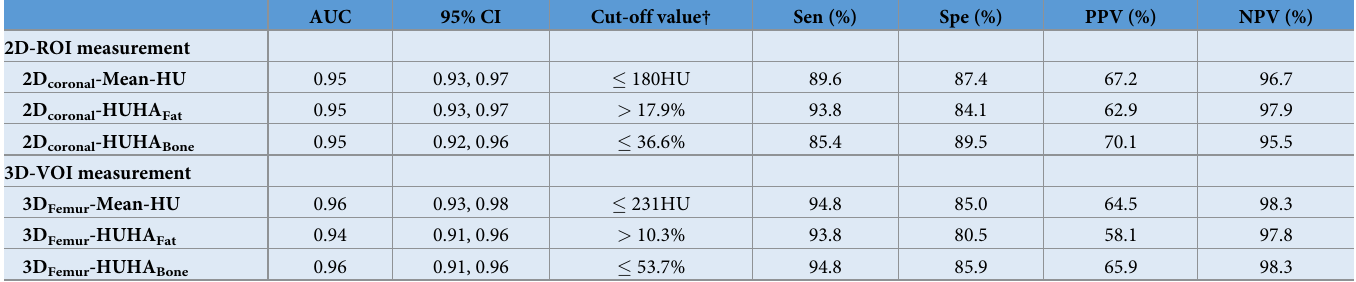
Table 3. Summary of the diagnostic accuracy of HUHA Fat , HUHA Bone , and mean-HU according to the 2D-ROI and 3D-VOI measurement location (osteoporosis was defined as a DXA femur T-score � − 2.5). AUC